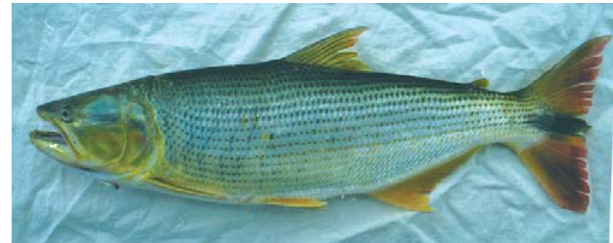
Fig. 4. Map of eastern and northeastern Brazil showing the distribution of Salminus franciscanus . A square indicates the type